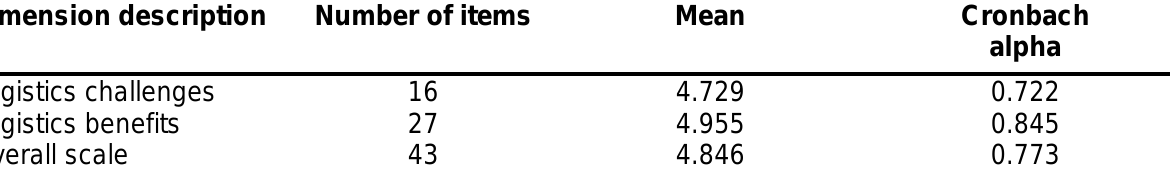
Table 3: Mean and internal consistency of scales Dimension description